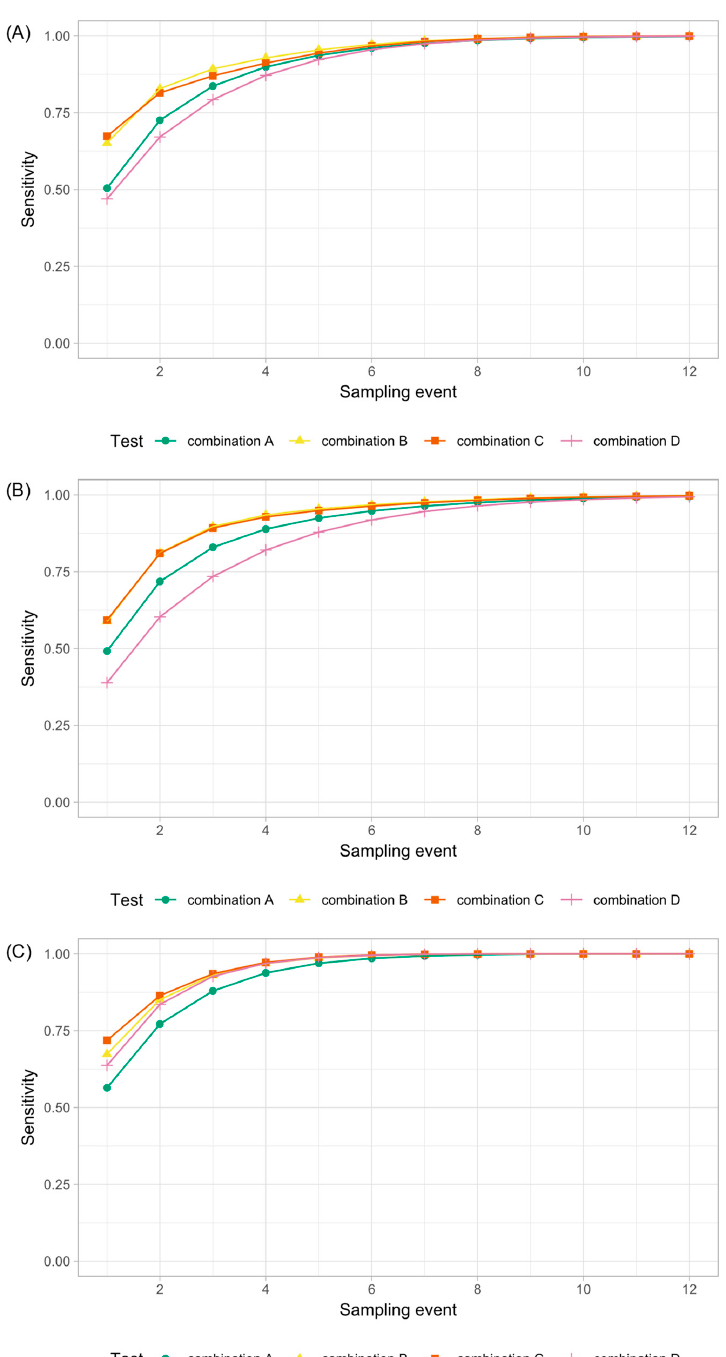
Figure 3. Cumulative sensitivity of different test combinations for the detection of MAP in large low-prevalence dairy herds. ( A ) Model run with the data of all study herds. ( B ) Model run with the data of all MAP non-suspect herds (group 0) and all MAP-infected herds with a within-herd prevalence of MAP-shedders of less than 2% (group 1). ( C ) Model run with the data of all MAP non-suspect herds (group 0) and all MAP-infected herds with a within-herd prevalence of at least 2% (group 2). Combination A: sample sock + milk pools of size 50; Combination B: pool of liquid manure and fecal samples from the barn environment (feces from the milking area, the main alleyway, and the lactating cow floor) + milk pools of size 50; Combination C: fecal samples from the barn environment (milking area, the main alleyway, and the lactating cow floor) + milk pools of size 50; Combination D: sample sock + pool of liquid manure and fecal samples from the barn environment (feces from the milking area, the main alleyway, and the lactating cow